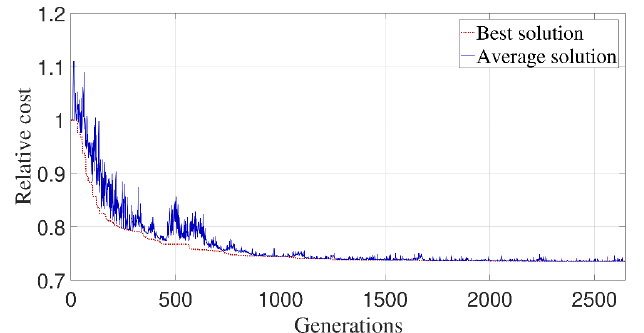
Figure 12. Convergence history - Example II: case I.